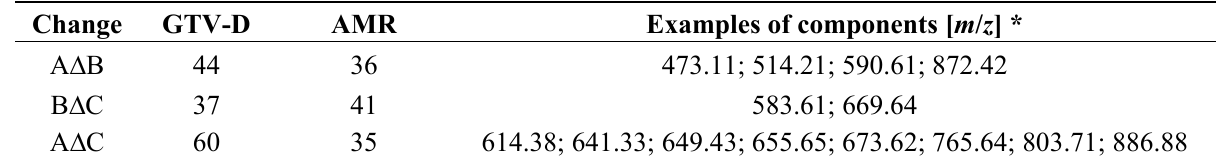
Table 3. Serum lipidome features associated with radiation doses and acute radiation toxicity.